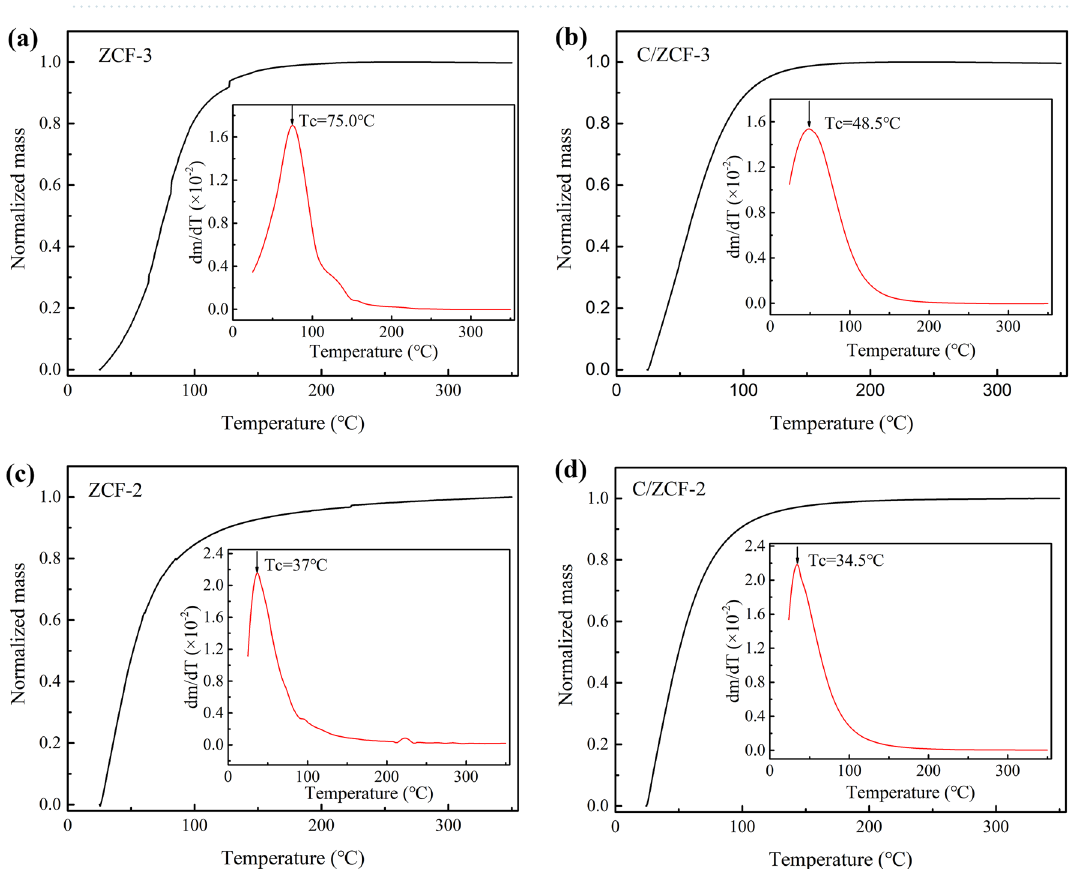
Figure 6. The thermogravimetric curves of MNPs under a static magnetic field: ( a ) ZCF-3, ( b ) C/ZCF-3, ( c ) ZCF-2, ( d ) C/ZCF-2. The insets are the first derivative of the corresponding thermogravimetric curves, where the temperature corresponding to the maximum value is defined as the Curie